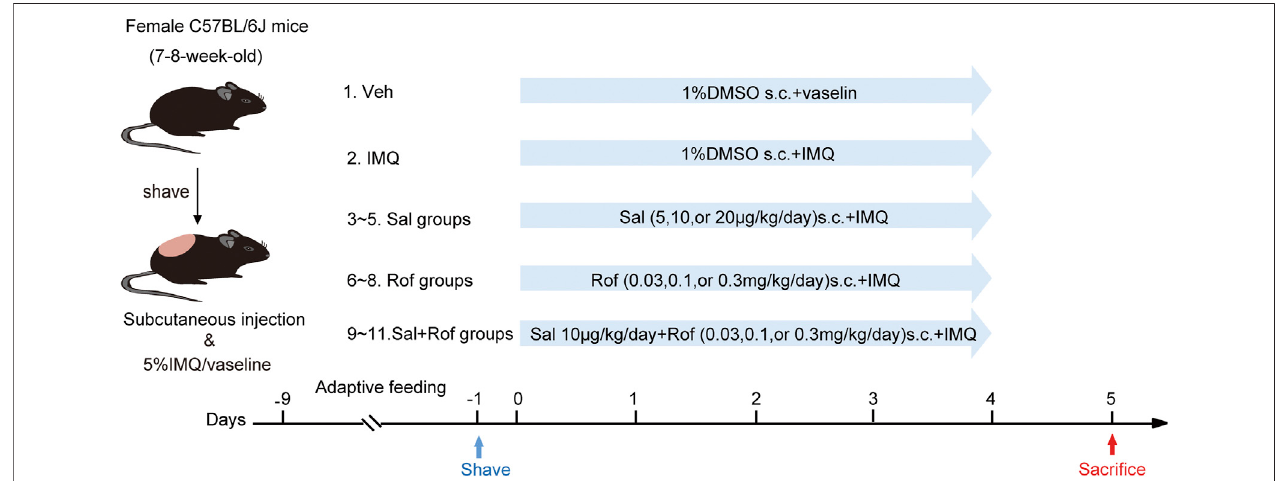
FIGURE 1 | Pharmacological intervention of psoriasis-like dermatitis induced by IMQ in mice. Experimental scheme of psoriasis-like dermatitis induced by IMQ in mice. Sal, Rof, and the combination of Sal and Rof were subcutaneously administered under the skin for 5 days.